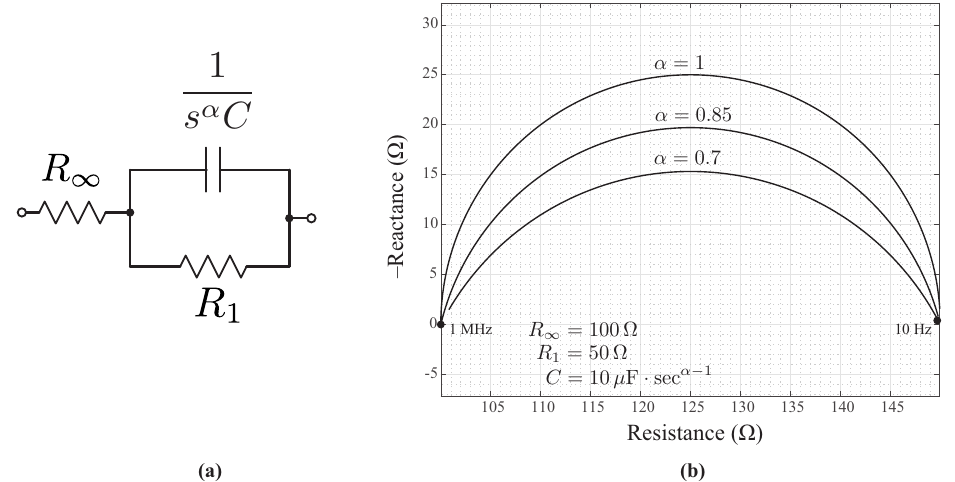
Figure 1. ( a ) Electrical circuit representation of the Cole-impedance expression [1] and ( b ) MATLAB simulated Nyquist plot of (2) with R ∞ = 100 Ω , R 1 = 50 Ω , C = 10 µ F